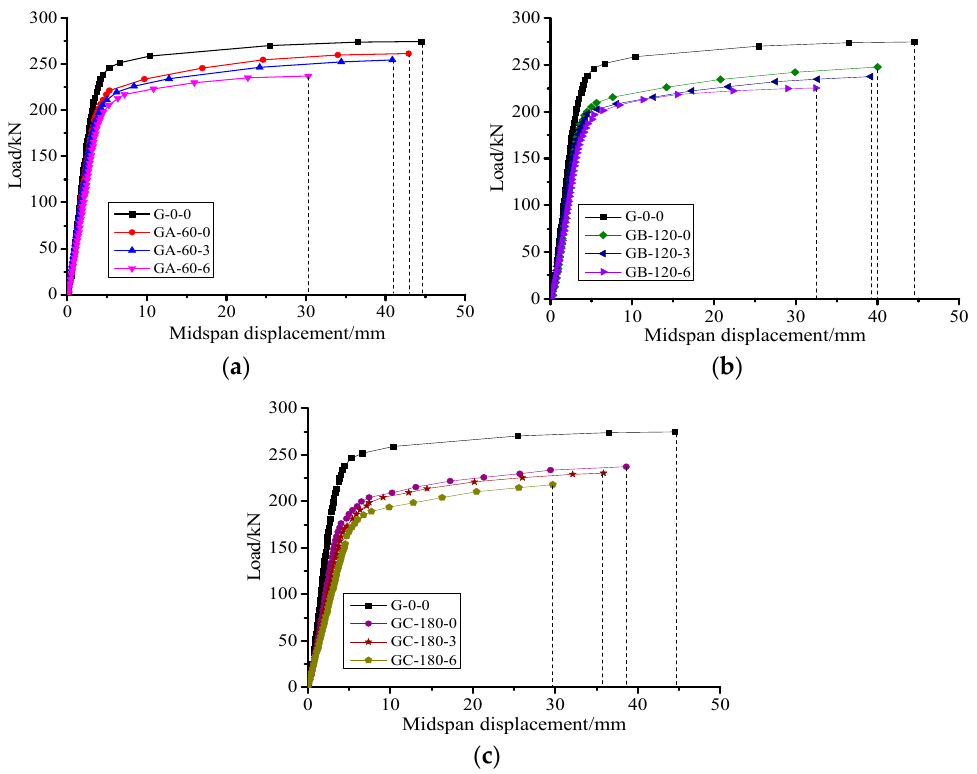
Figure 12. Load ‐ displacement curves of corroded beams: ( a ) Group A; ( b ) Group B; ( c ) Group C.